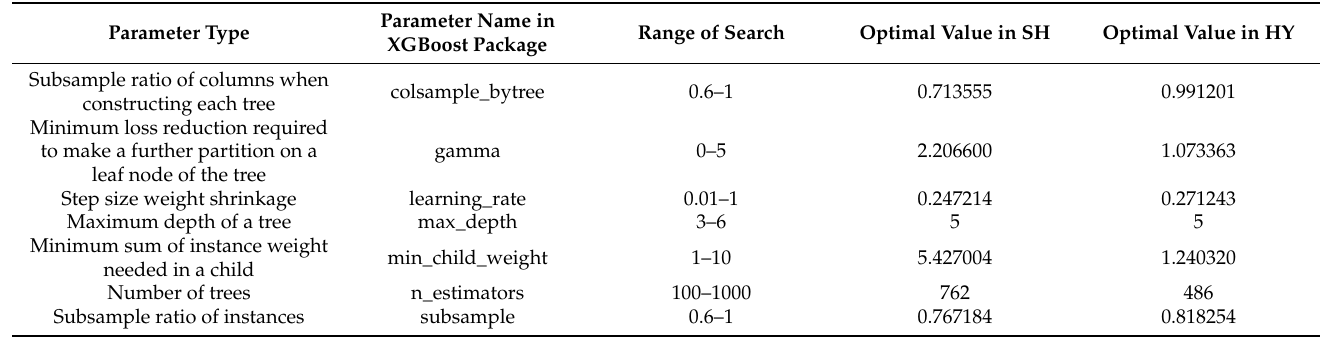
Table 1. XGBoost Hyperparameter tuning. The list of parameters, the description, and the name of the parameter in the XGBoost package are given in the table in addition to the range in which the parameters were optimized as well as the optimal values in SH and